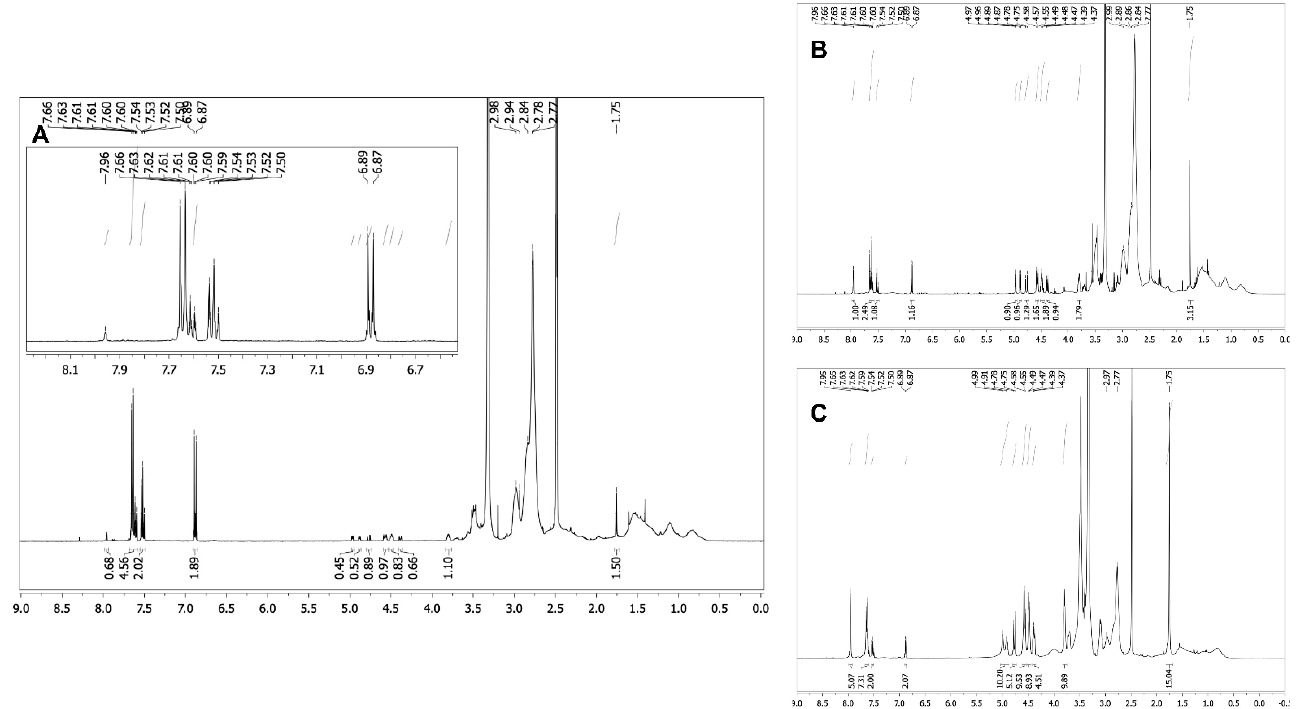
Figure 2. 1H-NMR spectra (600 MHz) of the 5%—( A ), 10%—( B ) and 25%—( C ) GlcNAc-4EG polymers (Table 1). The GlcNAc and 4-hydroxymethyl triazoles proton gave a distinct singlet at 7.96 ppm, whereas the benzophenones aromatic protons gave signals from 7.66 to 6.67 ppm. Furthermore, the GlcNAc acetyl group singlet showed a signal at 1.75 ppm. The broad multiplet from 2.98 to 2.75 ppm belongs to the dimethacrylamide methyl groups. Copolymer ratio was calculated by the integral ratios of triazole-H vs. NAc vs. aromatic benzophenone-H. For the 4-hydroxymethyl comonomers, only triazole-H was integrated vs. aromatic benzophenone-H. The figure shows the increasing triazole singlet (7.96 ppm) and NAc singlet (1.75 ppm) with increasing comonomer ratio of 11b vs. the aromatic protons of MBP 14 . The dimethacrylamide multiplet between 2.98 and 2.75 ppm was relatively constant in all three spectra because it overlays the tetraethylene glycol.